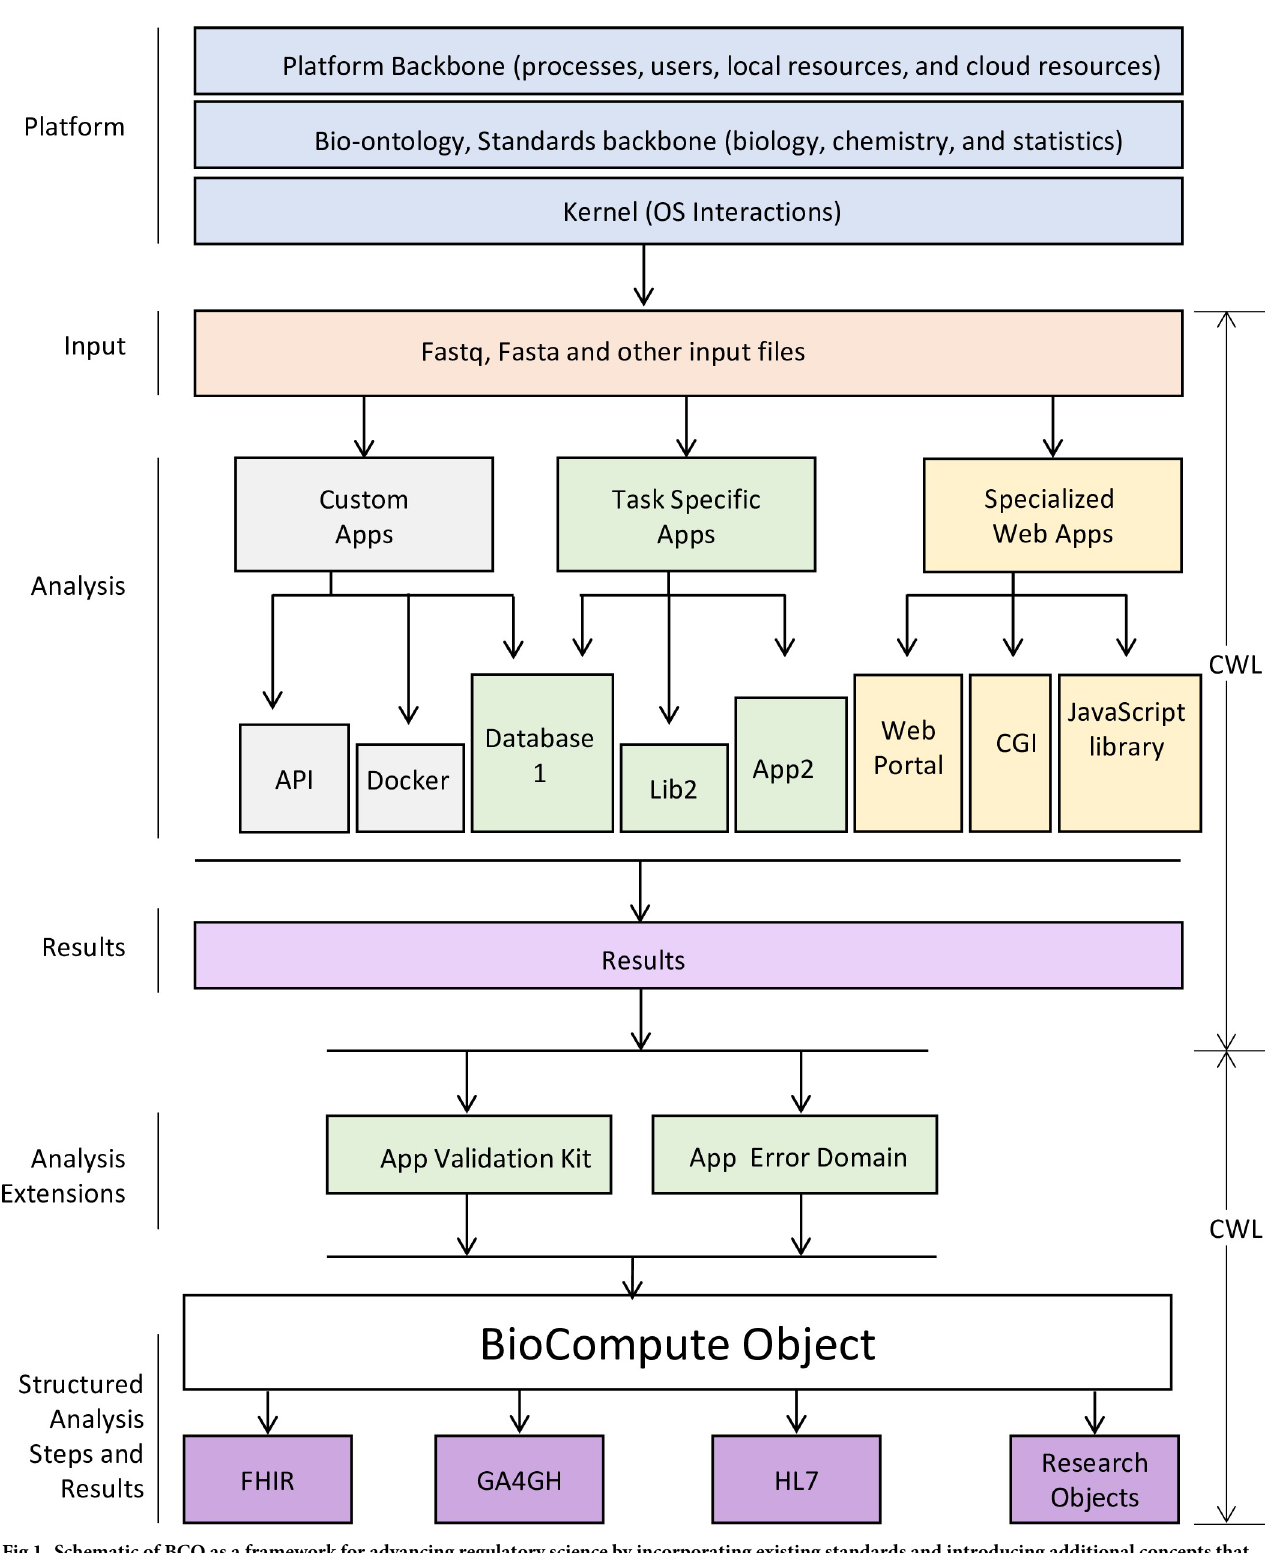
Fig 1. Schematic of BCO as a framework for advancing regulatory science by incorporating existing standards and introducing additional concepts that include digital signature, usability domain, validation kit, and error domain. API, application programming interface; app, application; BCO, BioCompute Object; CGI, computer graphic imaging; FHIR, Fast Healthcare Interoperability Research; GA4GH, Global Alliance for Genomics and Health; HL7, Health Level 7; OS, operating system. https://doi.org/10.1371/journal.pbio.3000099.g001 PLOS Biology | https://doi.org/10.1371/journal.pbio.3000099 December 31,